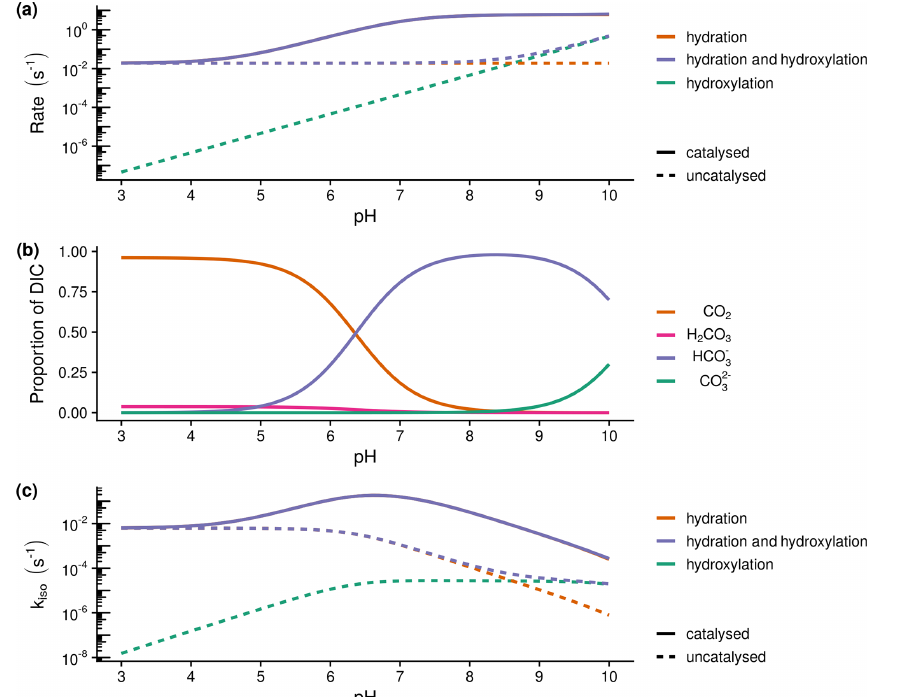
Figure 1. Theoretical calculations of the expected relationship between the rate of hydration ( k h ) and hydroxylation reactions, the speciation of dissolved inorganic carbon (DIC) and the rate of oxygen isotope exchange ( k iso ): (a) expected variations in the rate of hydration ( k h ) and hydroxylation reactions with pH at 21 ◦ C calculated following Uchikawa and Zeebe (2012) and Sauze et al. (2018). Dashed lines indicate uncatalysed rates, whilst solid lines include the presence of 200nM of carbonic anhyrdrase with k cat /k m = 3 × 10 7 Ms − 1 and a pka of 7.1. The catalysed rate of hydration decreases under acidic conditions as high proton concentrations limit enzyme regeneration, (b) speciation of dissolved inorganic carbon (DIC) calculated from rate constants at 21 ◦ C, and (c) expected variations in the rate of isotope exchange ( k iso ) with pH calculated as in the first panel (a) . The rate of exchange is limited by enzyme regeneration under acidic conditions and the availability of CO 2 under alkaline